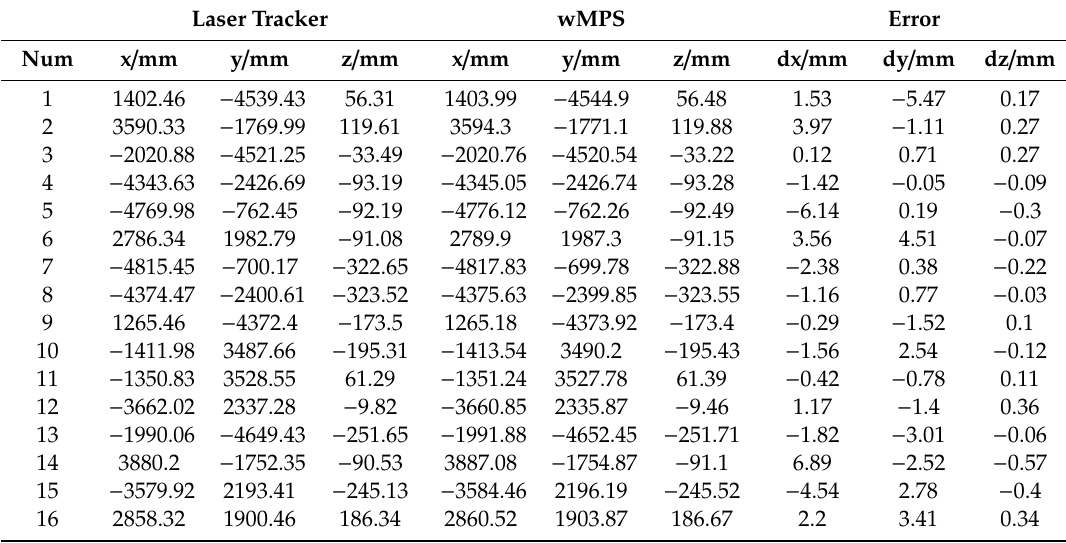
Figure 9. Guidance error of trajectory experiments in 360° field: ( a ) ∆(cid:1876) is x-coordinate error; ( b ) ∆(cid:1877) is y-coordinate error; ( c ) ∆(cid:1878) is z-coordinate error.